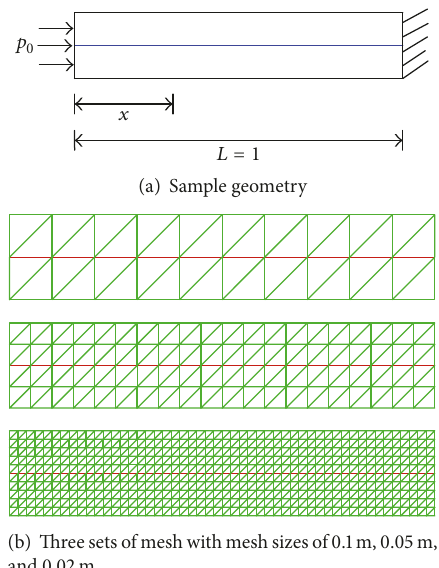
Figure 11: Rock sample with a single